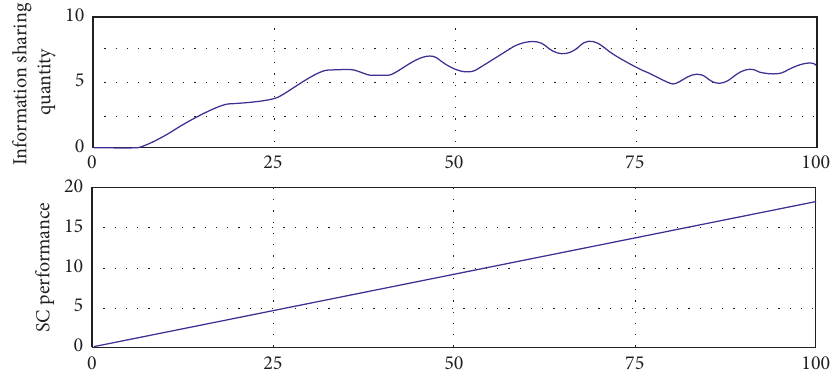
Figure 5: Indirect and direct effects of IS on SC